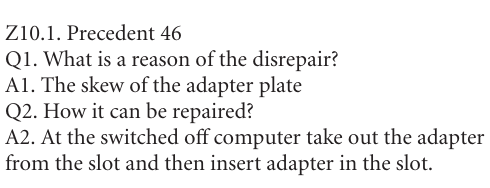
Algorithm 5: QA-program of